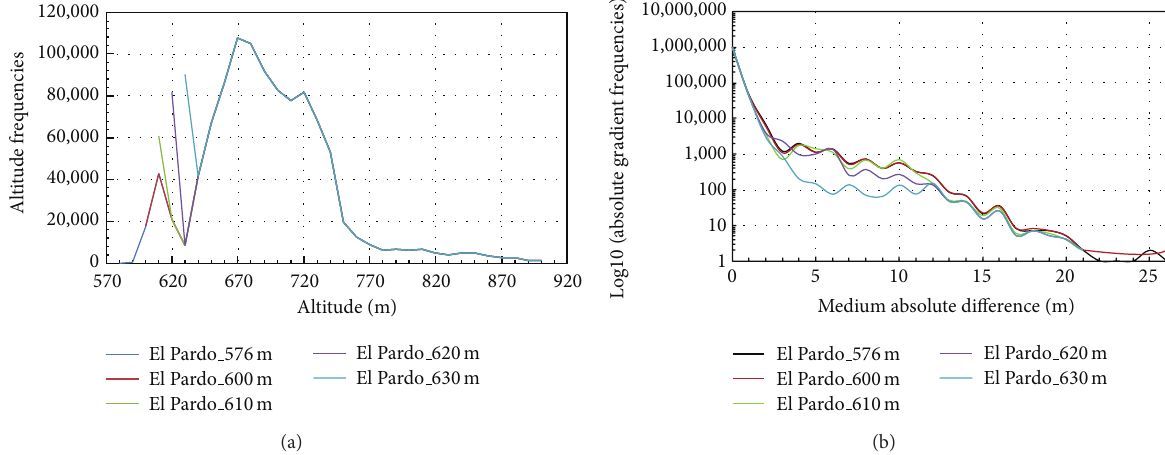
Figure 3: Frequencies distribution, with the water reservoir at different filling levels of (a) altitudes and (b) absolute gradient (frequency in logarithmic scale).